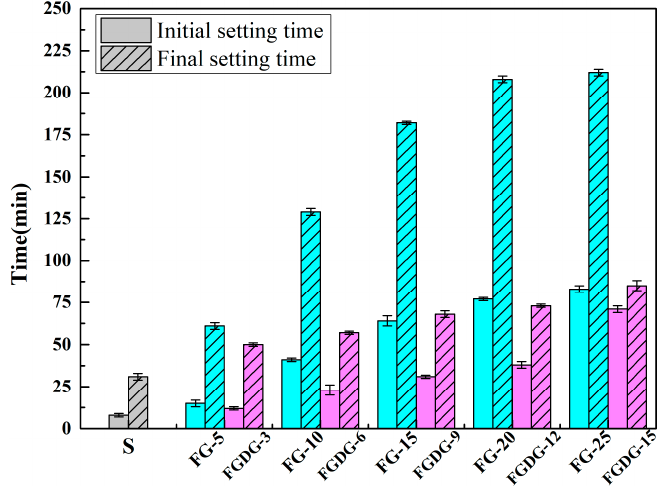
Figure 3. Effect of different gypsum content on setting time of paste.